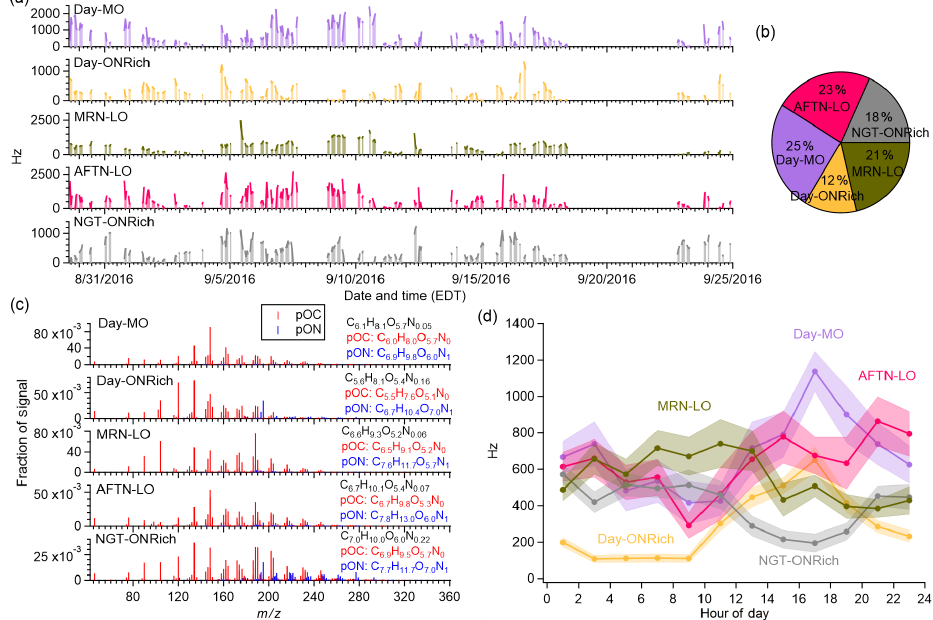
Figure 4. (a) Time series and study mean (b) fraction, (c) normalized mass spectra, and (d) diurnal profiles (standard deviations in shaded areas) of FIGAERO OA factors resolved by PMF. Note that the time series in (a) are shaded to guide the eyes.